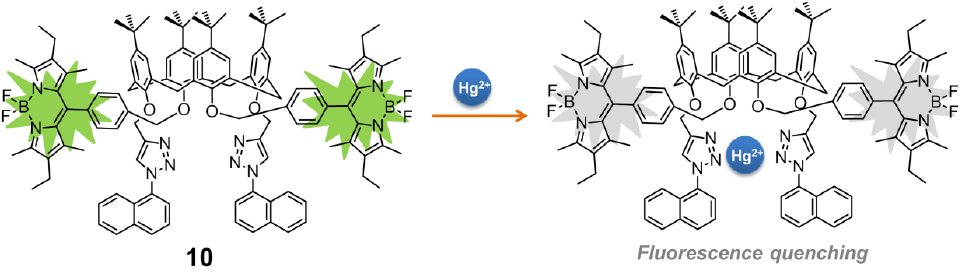
Figure 9. Chemical structure of calix[4]arene derived chemosensor 10 for the detection of Hg 2 +